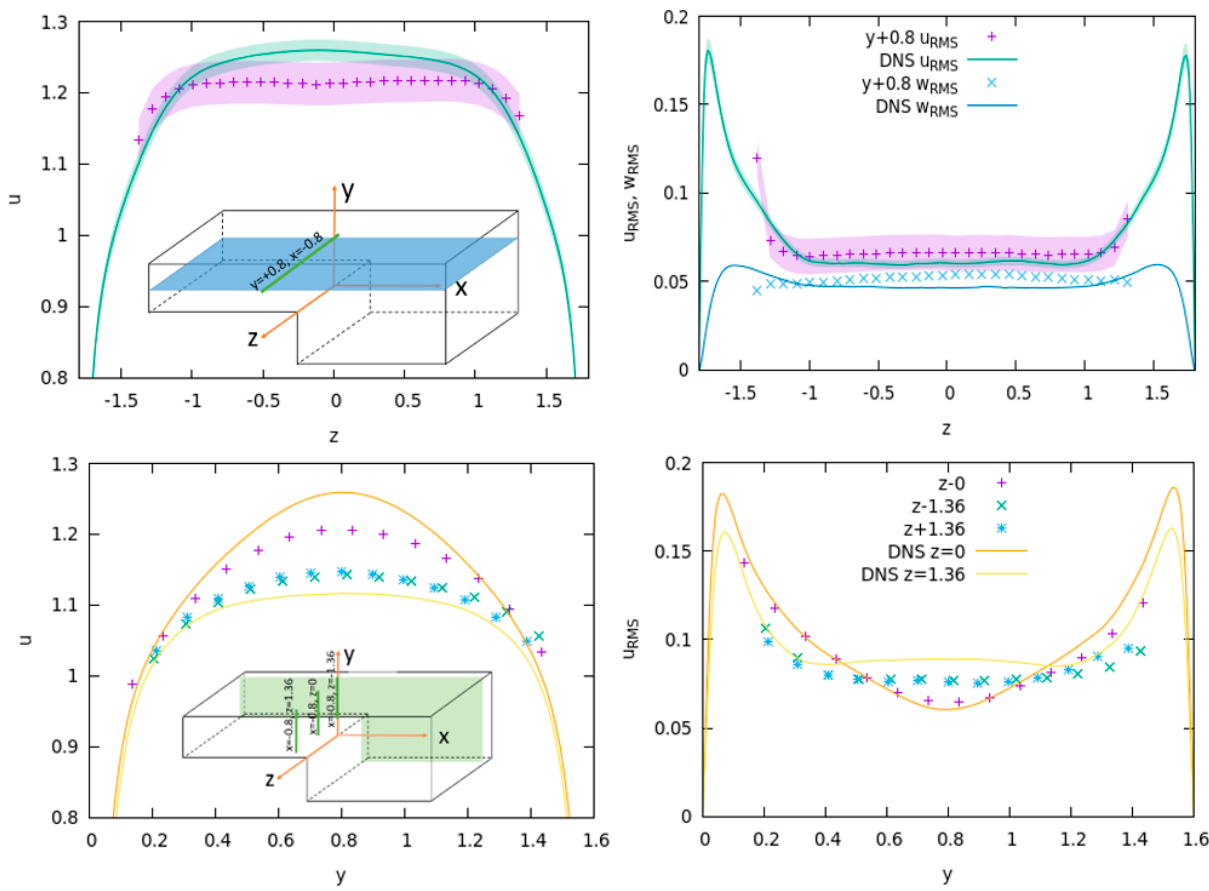
Figure 4. Top: profiles of u (left), u RMS , w RMS (right) at line segment x = − 0.8, case ‘y+0.8’ in Table 1 (green line on top inset Figure 4. Top : profiles of u ( left ), u RMS , w RMS ( right ) at line segment x = − 0.8, case ‘y + 0.8’ in Table 1 (green line on top drawing). Bottom: profiles of u (left), u RMS (right) at line segments x = − 0.8 in cases ‘z − 0’, ‘z − 1.36’, ‘z+1.36’ (green lines on inset drawing). Bottom : profiles of u ( left ), u RMS ( right ) at line segments x = − 0.8 in cases ‘z − 0’, ‘z − 1.36’, ‘z + 1.36’ bottom inset drawing). Symbols: PIV, lines: DNS. (green lines on bottom inset drawing). Symbols: PIV, lines: